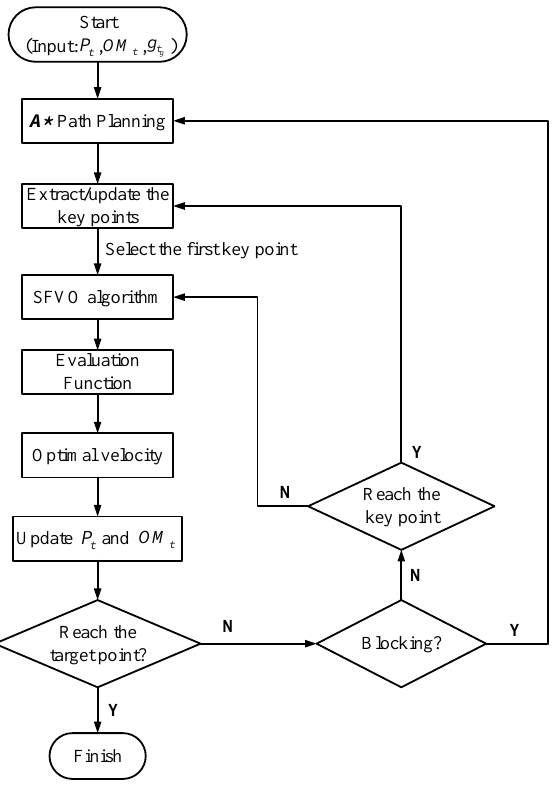
Figure 7. Flowchart of the hybrid